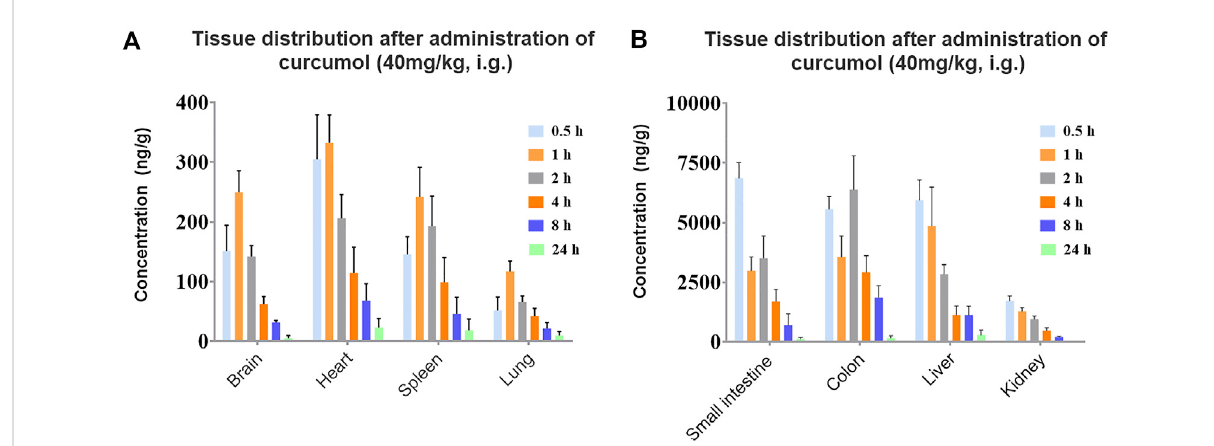
FIGURE 6 Concentration of curcumol in rat tissues after an oral administration of 40 mg/kg; (A) brain, heart, spleen, lung, (B) small intestine, colon, liver, kidney. ( n = 5, mean ±